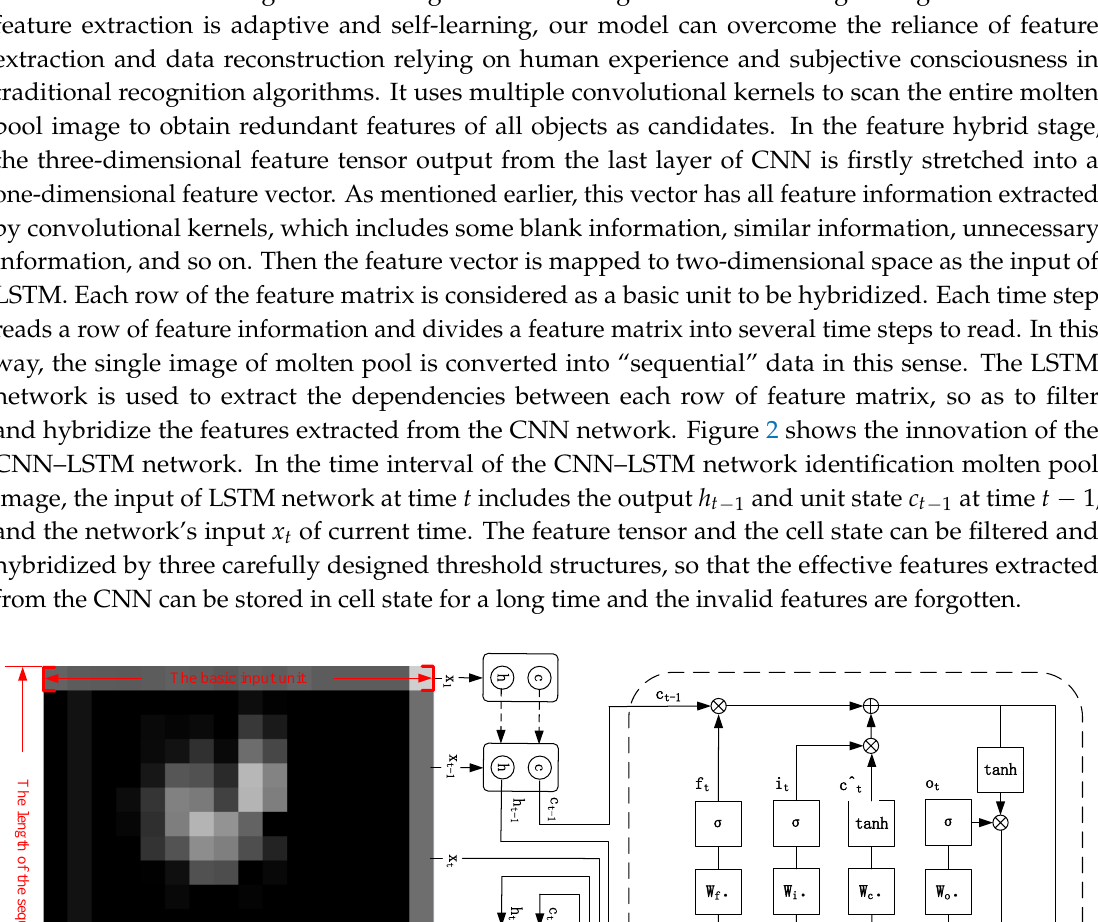
Figure 1. Convolutional neural network and long short-term memory network (CNN–LSTM) algorithm overall architecture.